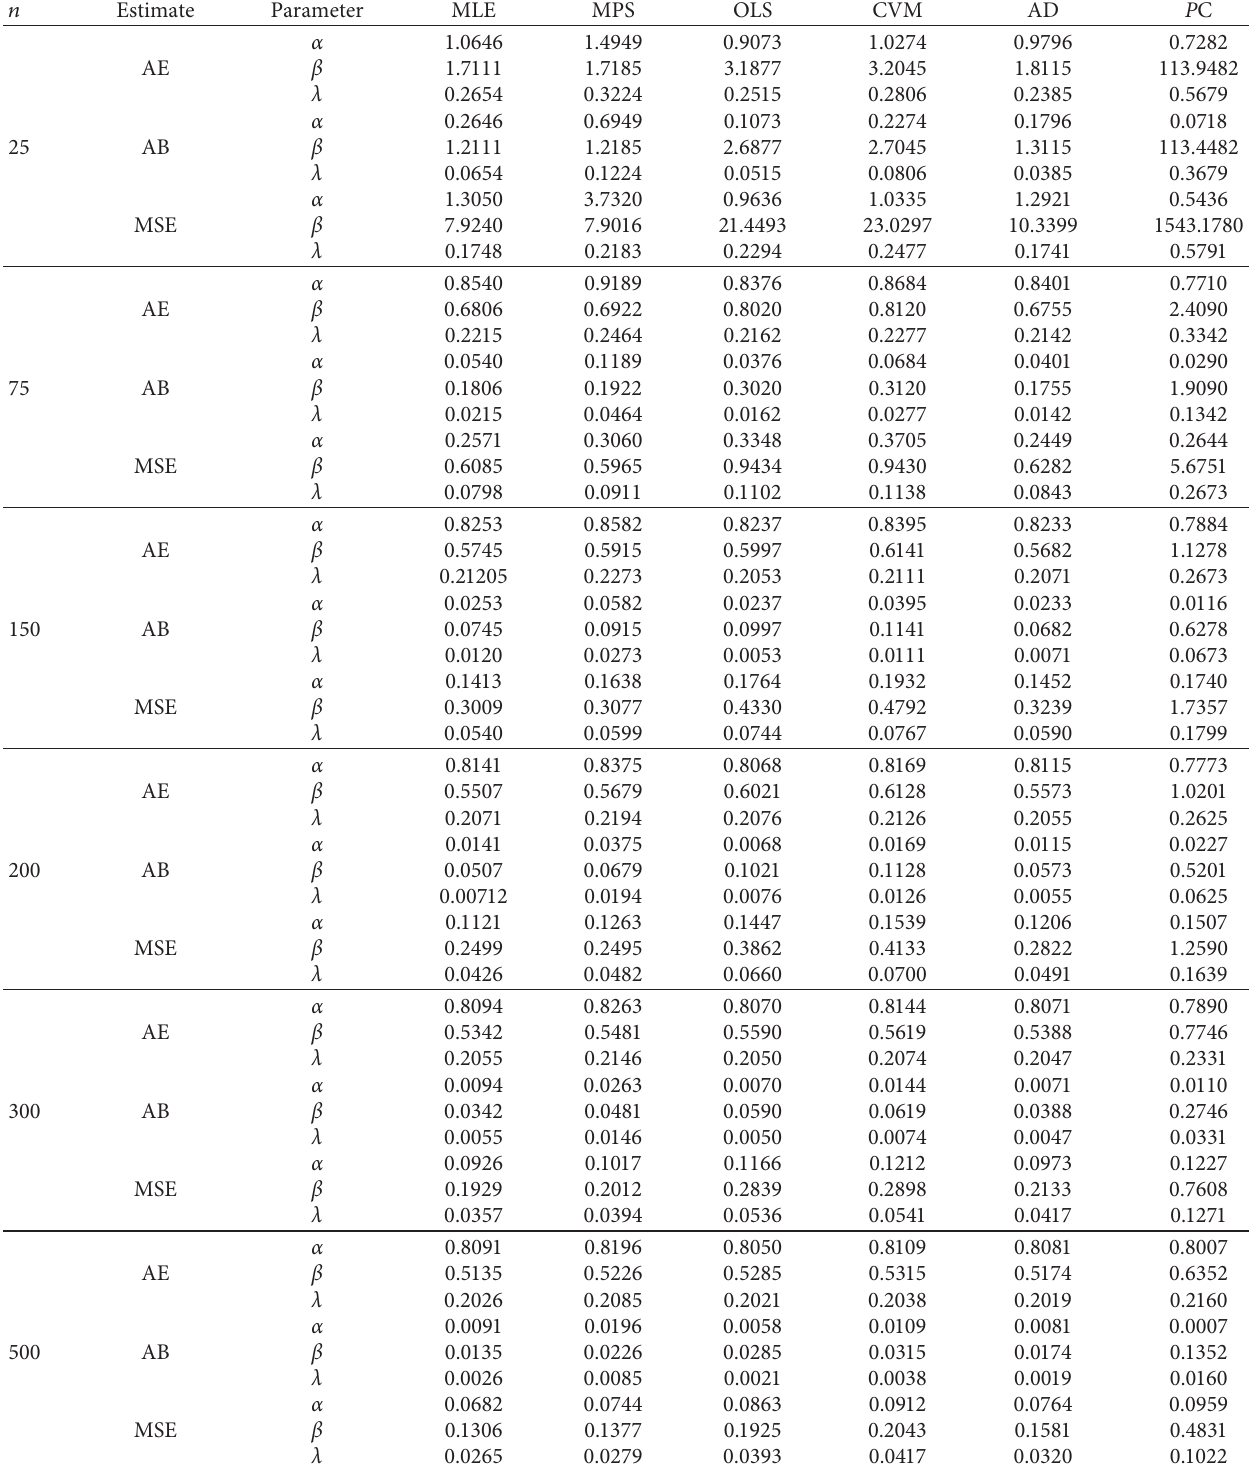
Table 2: Simulation results for α � 0 . 8 , β � 0 . 5, and λ � 0 .